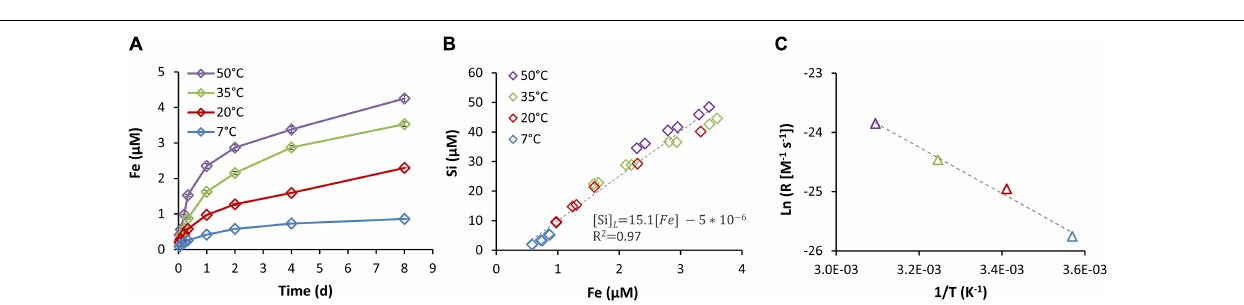
FIGURE 6 | Iron dissolution kinetics at various temperatures (7–50 ◦ C) in the presence of 90 µ M DFOB (A) . (B) Late stage (24–192 h) Si concentrations as a function of Fe concentrations. (C) Arrhenius plot showing the natural logarithm of the dissolution rate as a function of the inverse of temperature. From the slope of the Arrhenius plot an apparent activation energy of 32.4 kJ/mol is